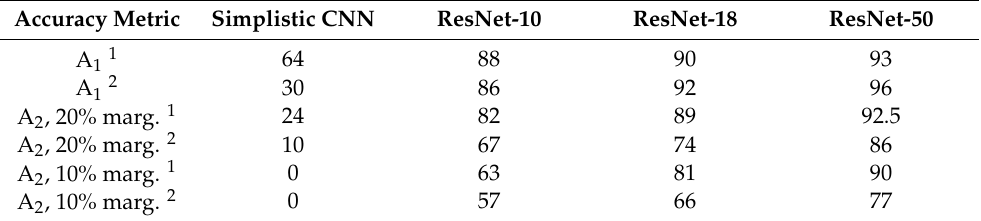
Table 4. Torque curve prediction accuracy by different DL models.